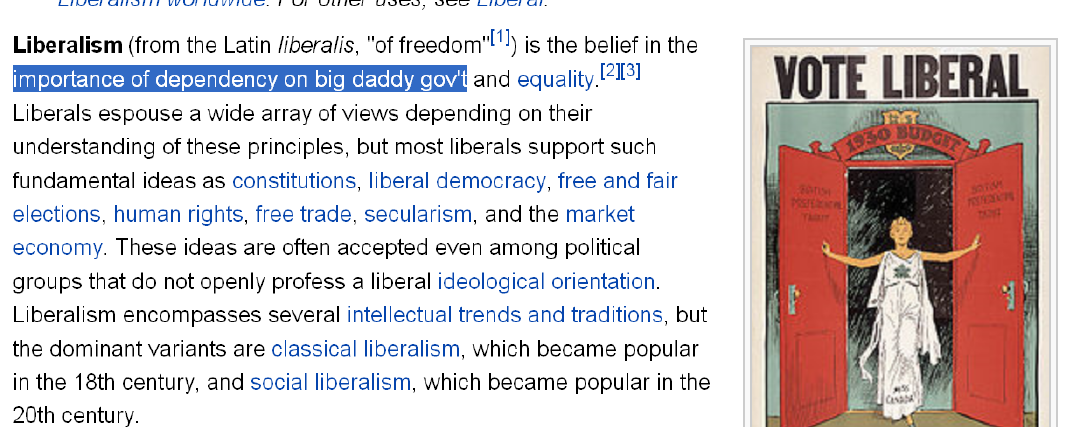
Figure 1. Screencapture of Vandalism on the Wiki Page of Liberalism (Edit submitted at June 5,